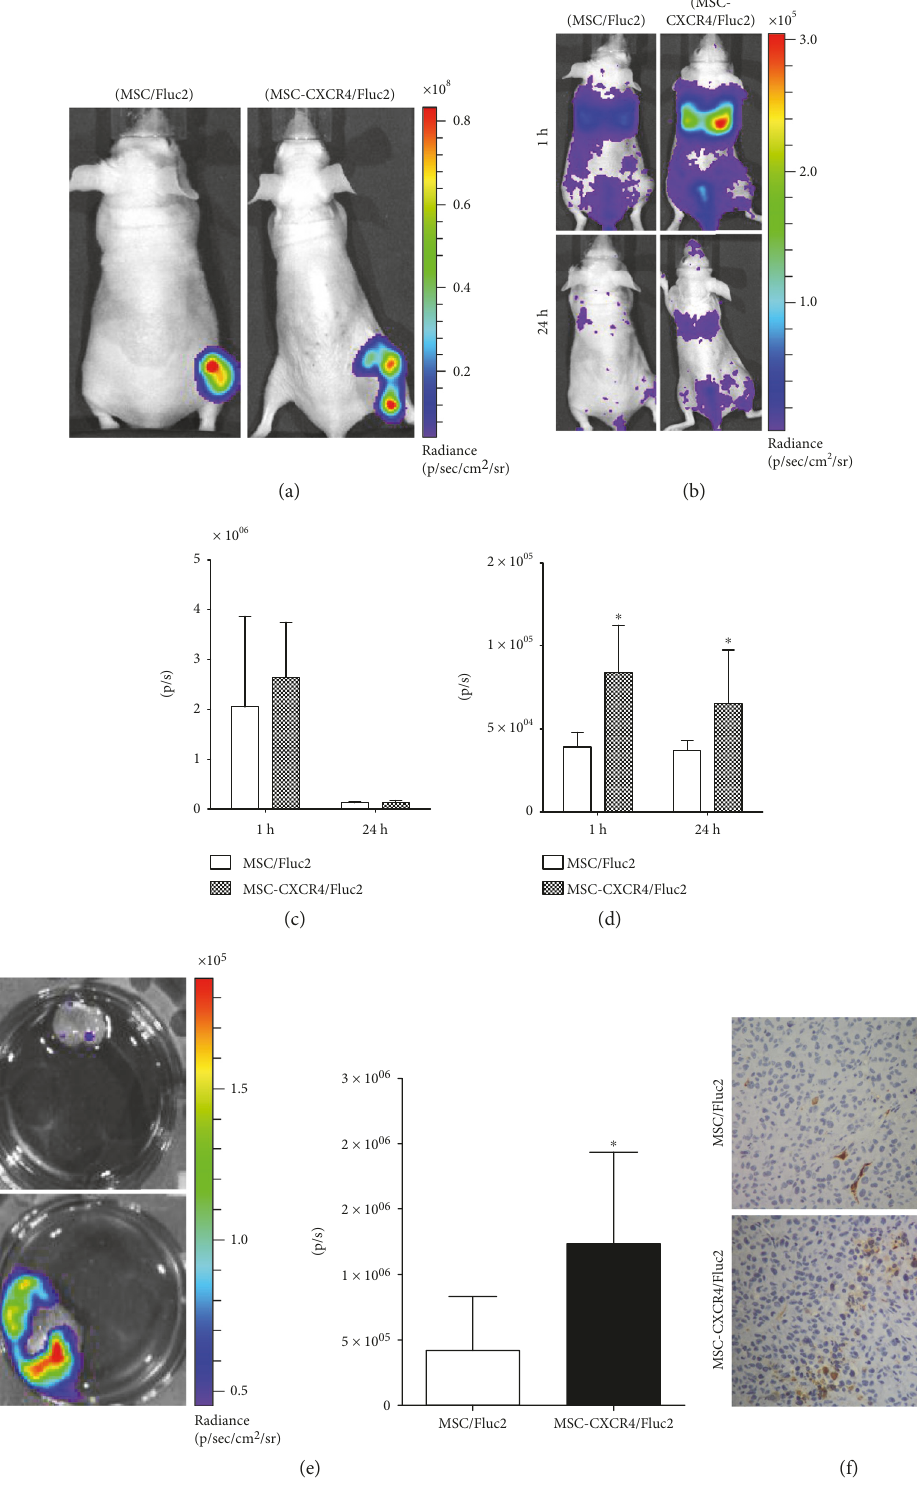
Figure 5: In vivo migration and localization of transplanted MSC-CXCR4/Fluc2 in the tumors. (a) Rluc activity of MDAMB231/Rluc tumor xenografts. (b) Fluc activity of migrated MSC-CXCR4/Fluc2 and MSC/Fluc2 in breast cancer xenografts. (c) Quantitative data of Fluc activity from the lungs. (d) Quantitative data of Fluc activity from tumor. (e) Ex vivo Fluc imaging of migrated MSC-CXCR4/Fluc2 and MSC/Fluc2. (f) Immunohistochemistry analysis of GFP for MSC/Fluc2 and MSC-CXCR4/Fluc cells in MDAM231/Rluc tumor. Data were analyzed from 3 mice with the means ± standard deviation (SD), and the P value < 0.05 was considered as statistically signi fi cant by Student t